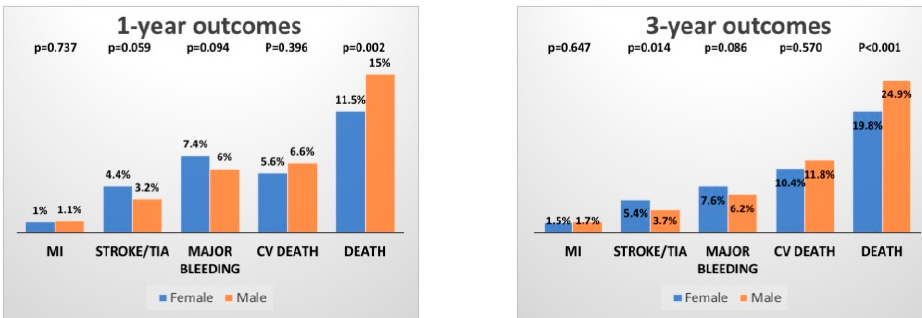
Figure 1. Cardiovascular outcomes after TAVR.